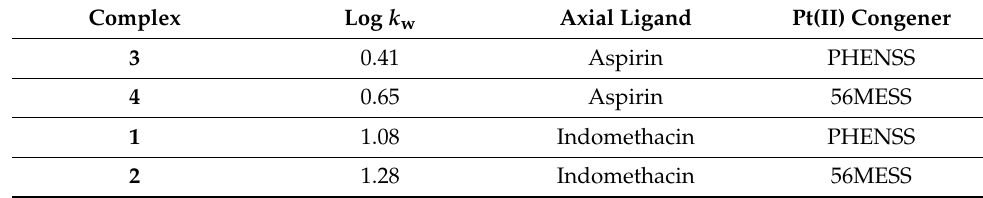
Table 1. The log k w of each complex with the type of platinum core and axial ligand. Complex Log k w Axial Ligand Pt(II)